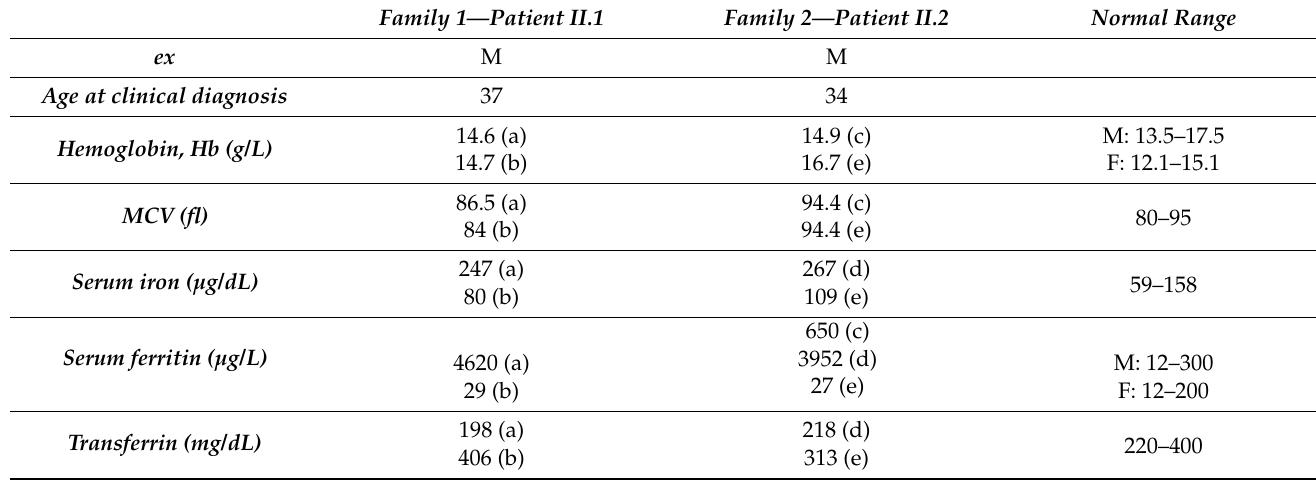
Table 1. Clinical, biochemical, and genetic data of patients affected of autosomal recessive non-HFE related HH due to HFE2 mutations. F, female; M, male. (a) Data before iron depletion. (b) Data after iron depletion. (c) Data at first analysis. (d) Second follow-up. (e) Most recent data (May 2020). n.a., not available. * Adult serum hepcidin reference values according to (Ganz et al., 2008) are: mean of 121 ng/mL (5–95% CI: 29–254 ng/mL) for men and mean of 87 ng/mL (5–95% CI: 17–286 ng/mL) for